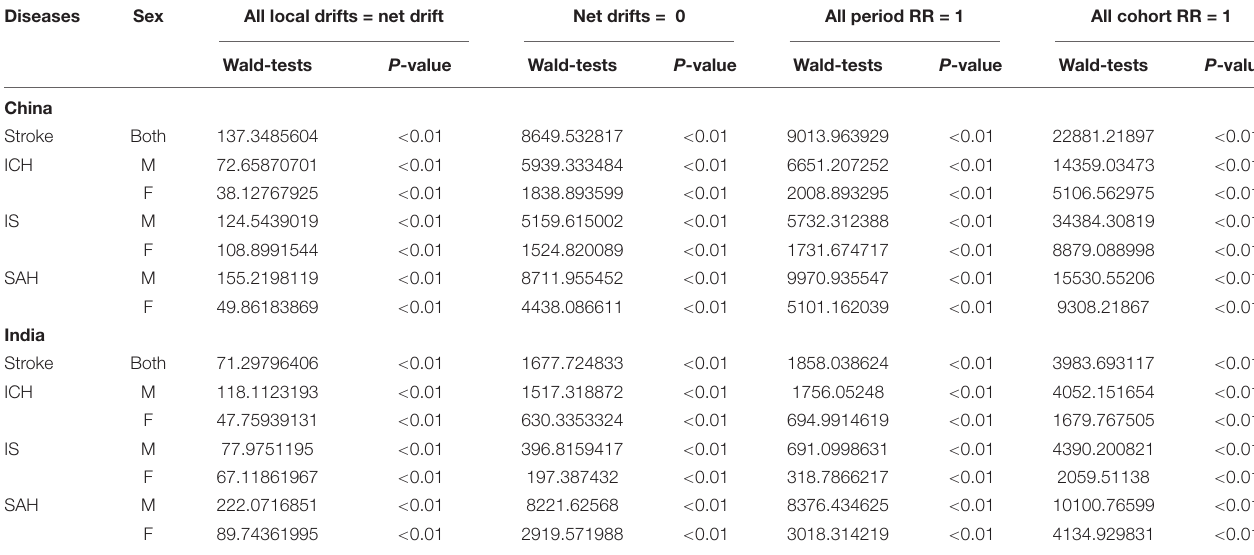
FIGURE 3 | Parameter estimates of age, period, and cohort effects on HAP-attributable subtype stroke mortality rate in China and India from 1990 to 2019. (A,D) , fitted longitudinal age curves of HAP-attributable intracerebral hemorrhage (ICH), ischemic stroke (IS), and subarachnoid hemorrhage (SAH) mortality (per 100,000 person-years) in China and India. (B,E) , the RRs of each period compared with the reference (2000–2004) adjusted for age and nonlinear cohort effects in China and India. (C,F) , the RRs of each cohort compared with the reference (cohort 1950–1954) adjusted for age and nonlinear period effects in China and India. TABLE 2 | Statistical parameters for overall- and age-specific annual percent changes in age-period-cohort